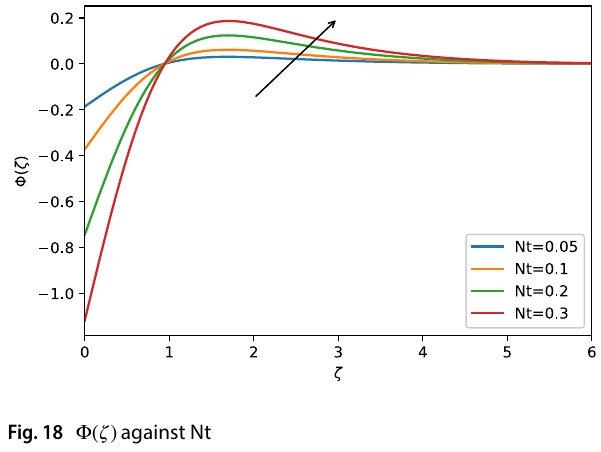
Fig. 18 Φ( 𝜁 ) against Nt